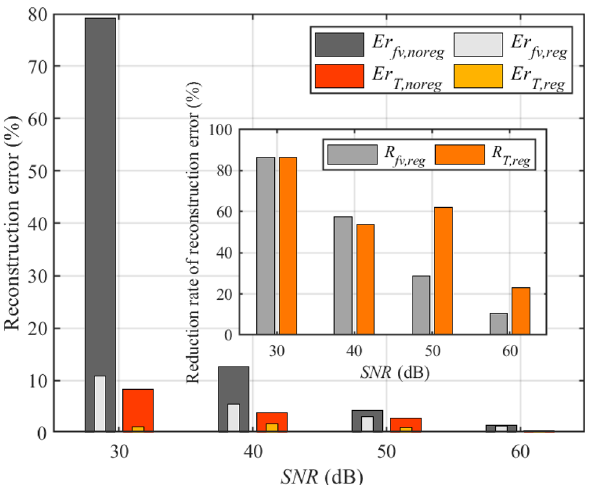
Figure 14. Comparing with the reconstruction without regularization, the improvement on the reconstruction errors of different SNR ( SNR = 30, 40, 50, 60 dB) with regularization parameters of 5. (External) The reconstruction errors of different SNR with and without regularization. (Internal) Comparing with the reconstruction errors without regularization, The reduction rate of reconstruction errors of different SNR with